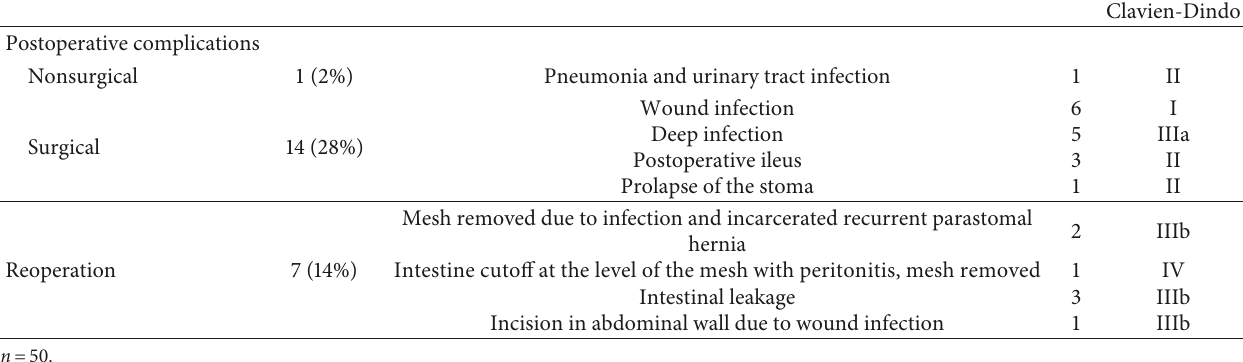
Table 2: One-month postoperative follow-up.